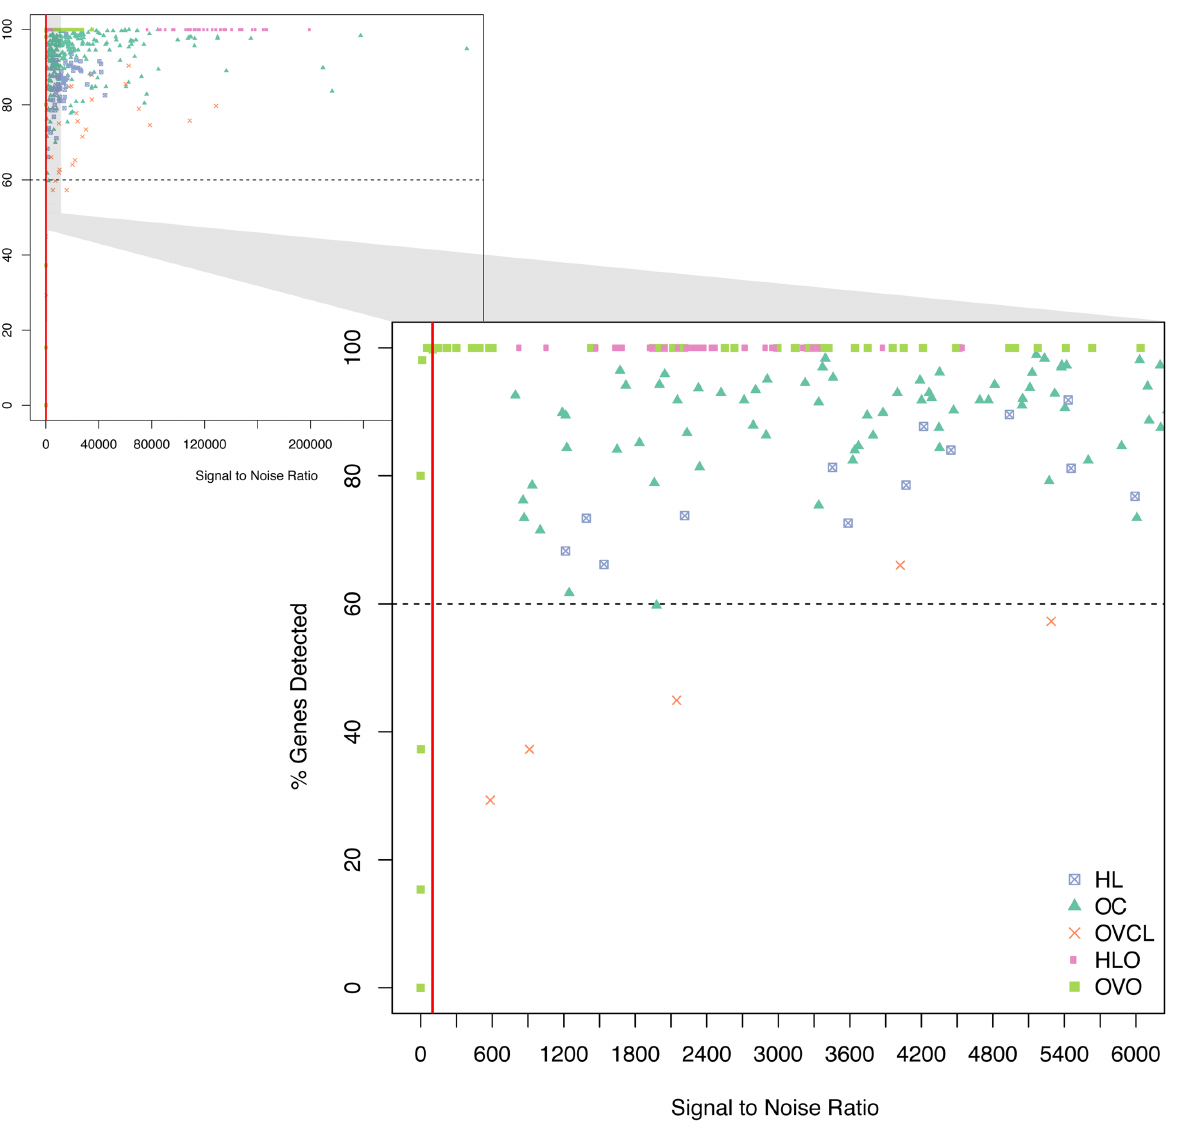
Fig 2. Percentage of genes detected as a function of Signal to Noise Ratio by cohort. Each point on the plot represents a NanoString nCounter unique run (duplicates and triplicates included where available). The zoomed in section illustrates how the selected cut-off excludes samples that have low signal to noise and low % genes detected. HL: Hodgkin lymphoma clinical samples, OC: ovarian cancer clinical samples, OVCL: ovarian cancer cell lines, HLO: oligonucleotides corresponding to the HL CodeSet, OVO: oligonucleotides corresponding to the OC